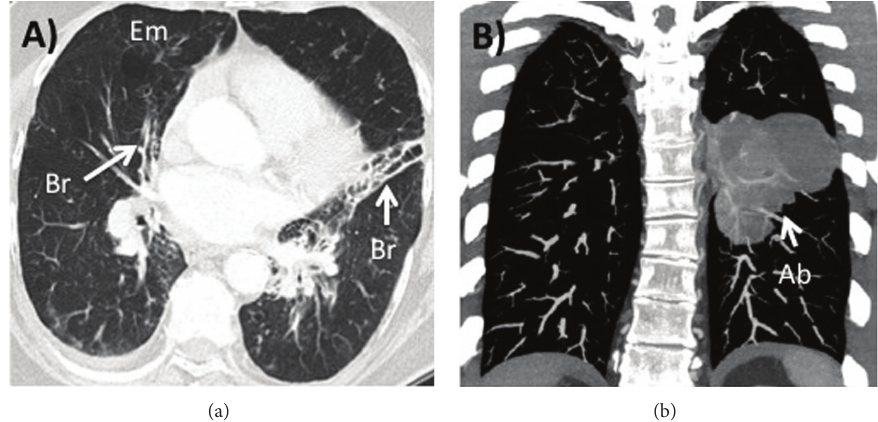
Figure 1: Clinical situations with NTHi infection. (a) shows a computed tomography (CT) scan of a subject with severe chronic obstructive pulmonary disease and the prescence of bronchiectasis (Br) and emphysema (Em). This patient had chronic NTHi airway colonization and exacerbations for a number of years. (b) shows a CT scan of a patient with Hyper IgE syndrome with a lung abscess (Ab) from which H. influenzae was